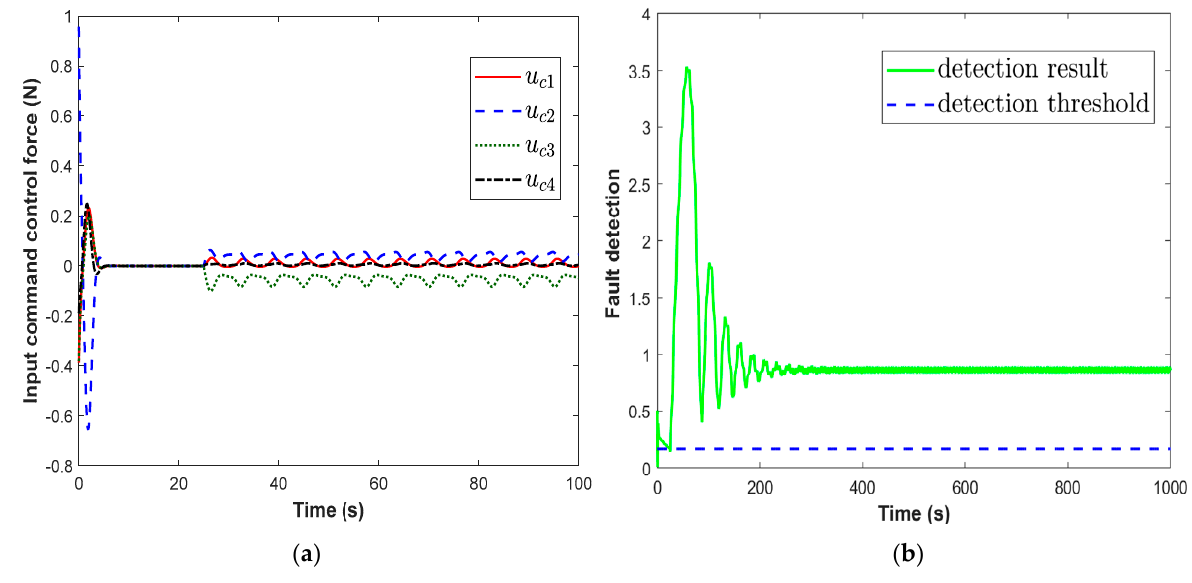
Figure 5. ( a ) Description of system control input; and ( b ) description of fault detection result.